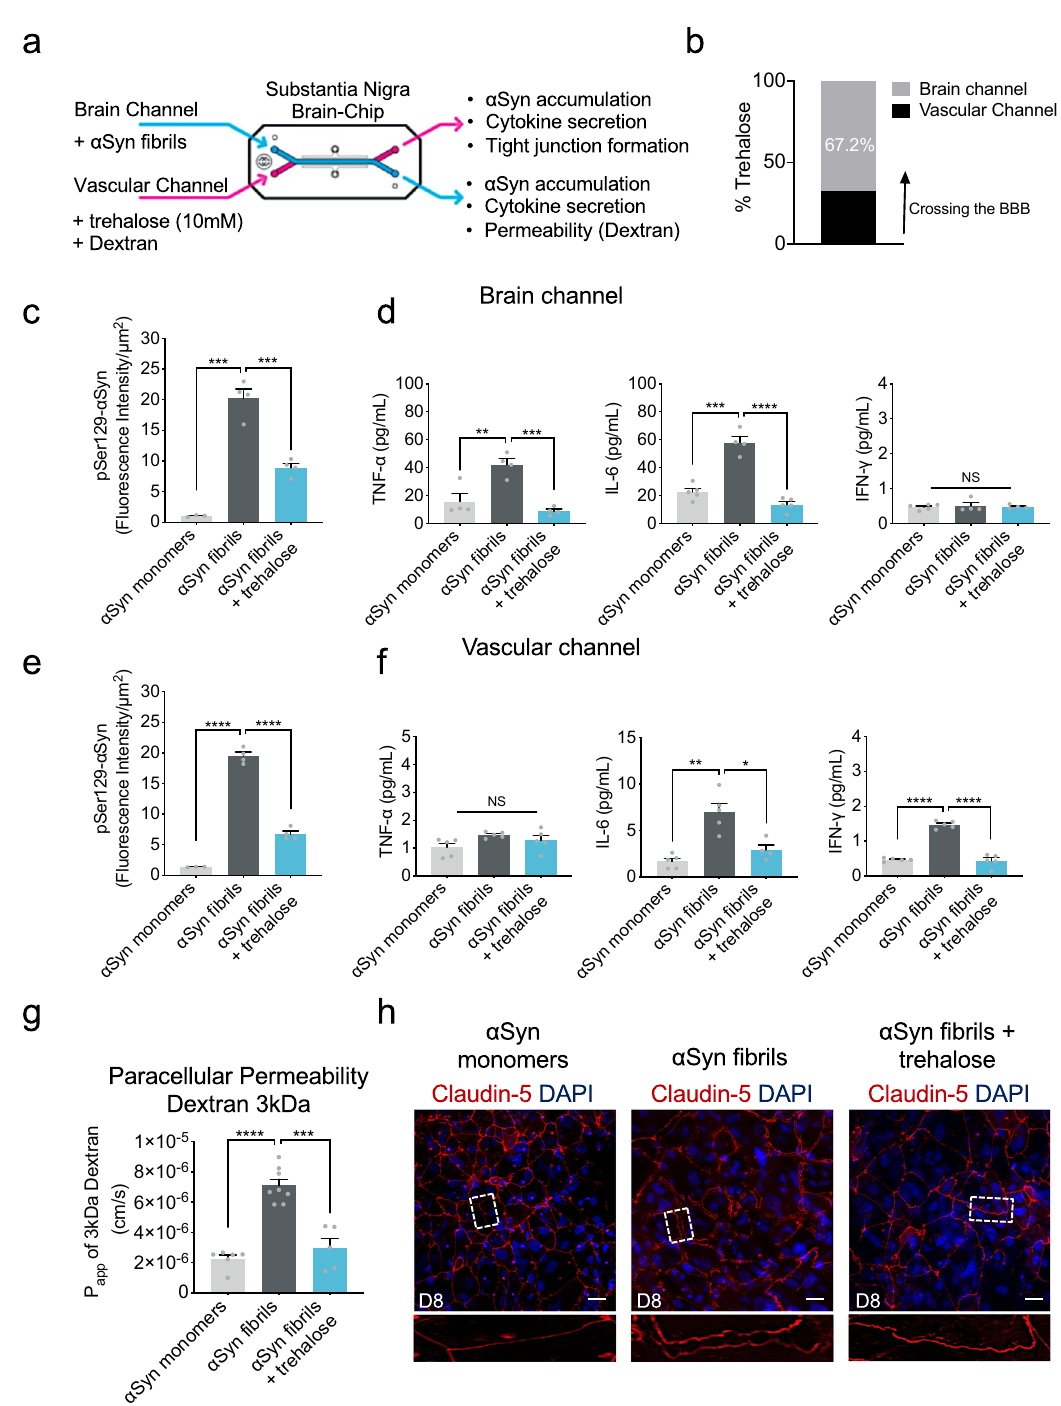
Our results show signs of tight junctions derangement and progressively compromised BBB permeability in response to α Syn fi brils. This is in line with previous studies showing deregulation of claudin as a key determinant of the BBB integrity and para- cellular permeability 89 . Transcriptomic analysis of the BBB endothelium from the Substantia Nigra Brain-Chip revealed that α Syn fi brils alter the expression of genes associated with distinct biological processes implicated in PD, including autophagy, oxi- dative stress, mitochondrial function, and in fl ammation. Excit- ingly, control over the amount of α Syn accumulation by treatment with the autophagy inducer trehalose rescued the NATURE COMMUNICATIONS| (2021) 12:5907